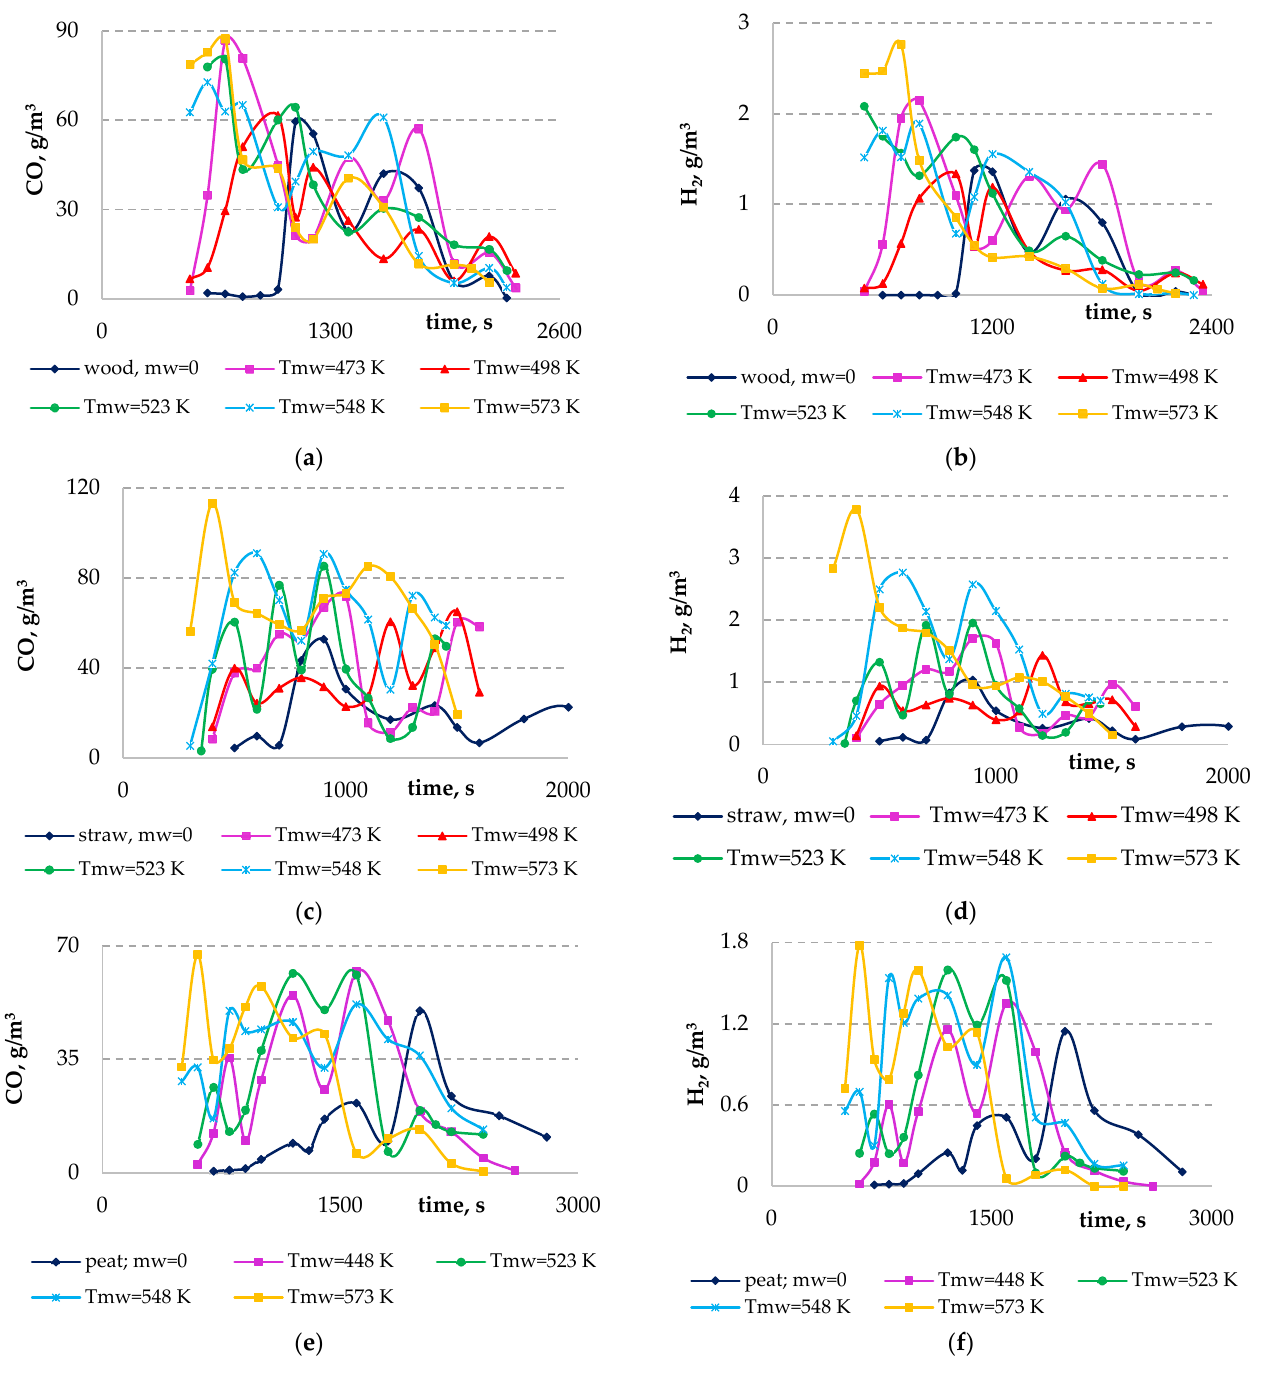
Figure 6. The effect of increasing the pre-treatment temperature on the kinetics of the yield of combustible volatiles (CO, H 2 ) during thermal decomposition of pre-treated pellets; ( a , b ) the yield of CO and H 2 at thermal decomposition of wood pellets; ( c , d ) the yield of CO and H 2 at thermal decomposition of wheat straw pellets; ( e , f ) the yield of CO and H 2 at thermal decomposition of peat